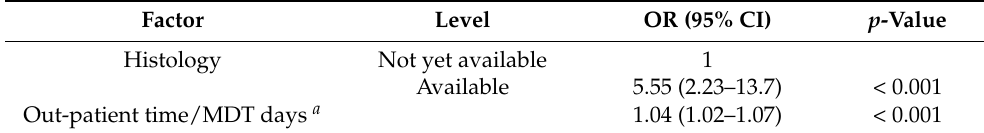
Table 5. Multivariable analysis of factors associated with modification for the locally advanced lung cancer